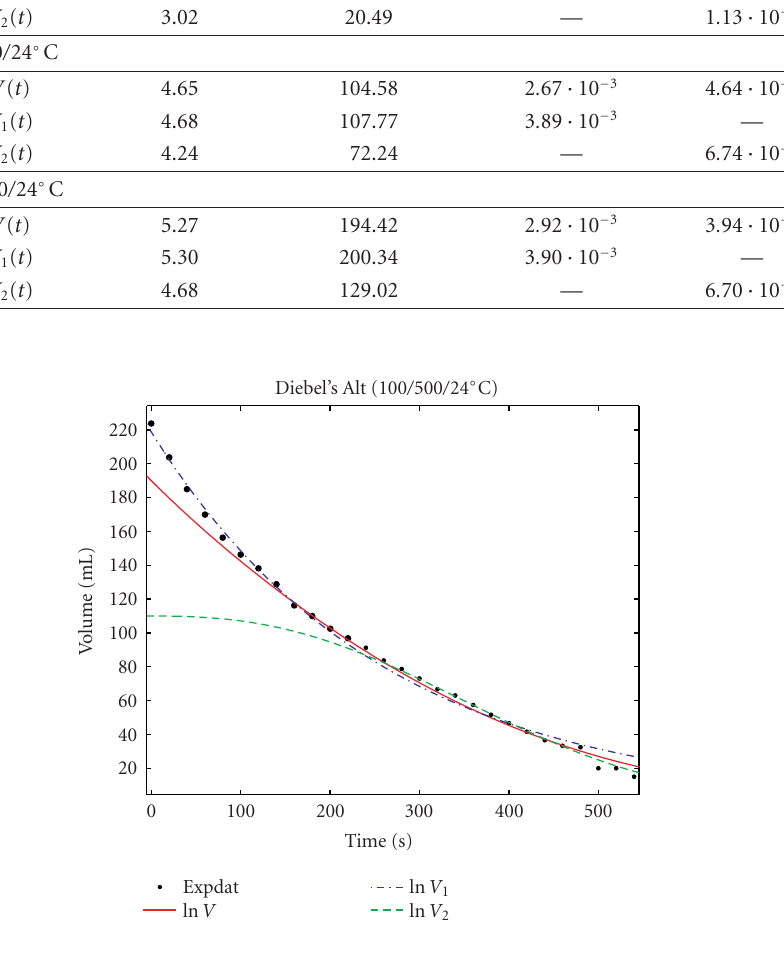
Figure 3.3. An example for the decay of beer foam which is not separable under these conditions.